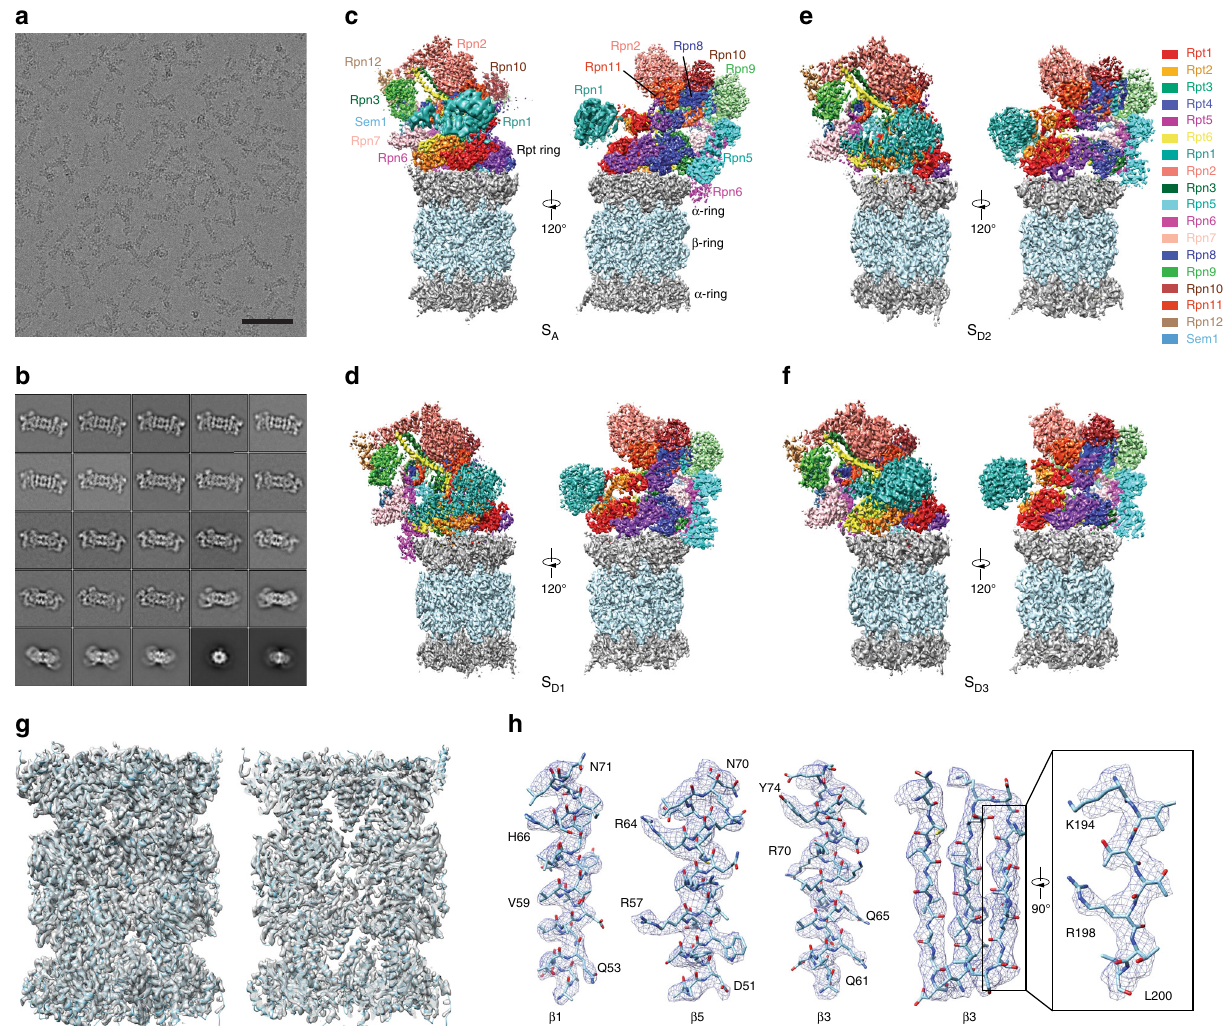
Fig. 1 Cryo-EM structure determination of the ATP- γ -S-bound human proteasome. a A typical cryo-EM micrograph of the ATP- γ -S-bound human proteasome imaged with a Tecnai Arctica microscope equipped with a Gatan K2 Summit direct detector camera. Scale bar, 100 nm. b Typical reference- free 2D class averages computed using the ROME software 35 . c – f Two different views of the cryo-EM density maps in the S A (panel c ), S D1 (panel d ), S D2 (panel e ), and S D3 (panel f ) states, colored according to subunit. g The 3.5-Å cryo-EM density of the CP in the combined S D state superimposed over its atomic model. Left, a lateral perspective. Right, a central slice. h Typical high-resolution densities of the secondary structures in the cryo-EM structure of the CP in the open-gate S D